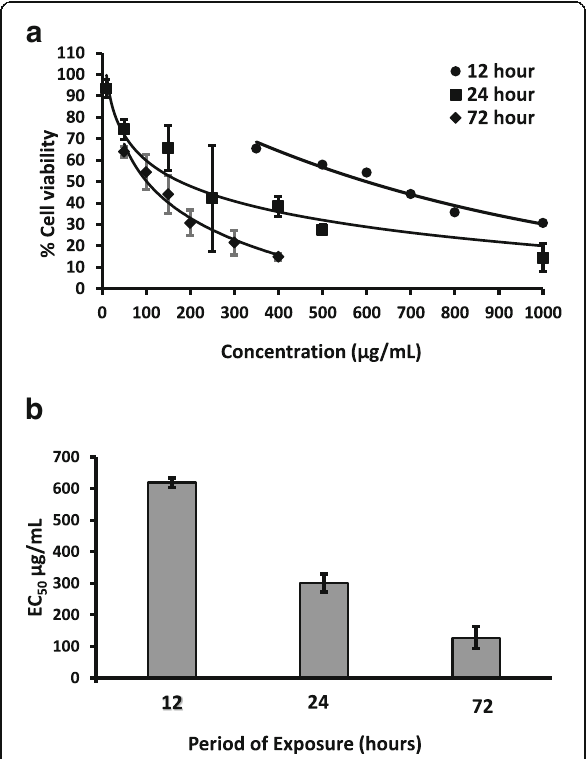
Fig. 1 The HPLC fingerprints obtained at a concentration of 500 μ g/mL. The Figure represents of a chromatogram from triplicate of individually prepared lyophilized plant extracts